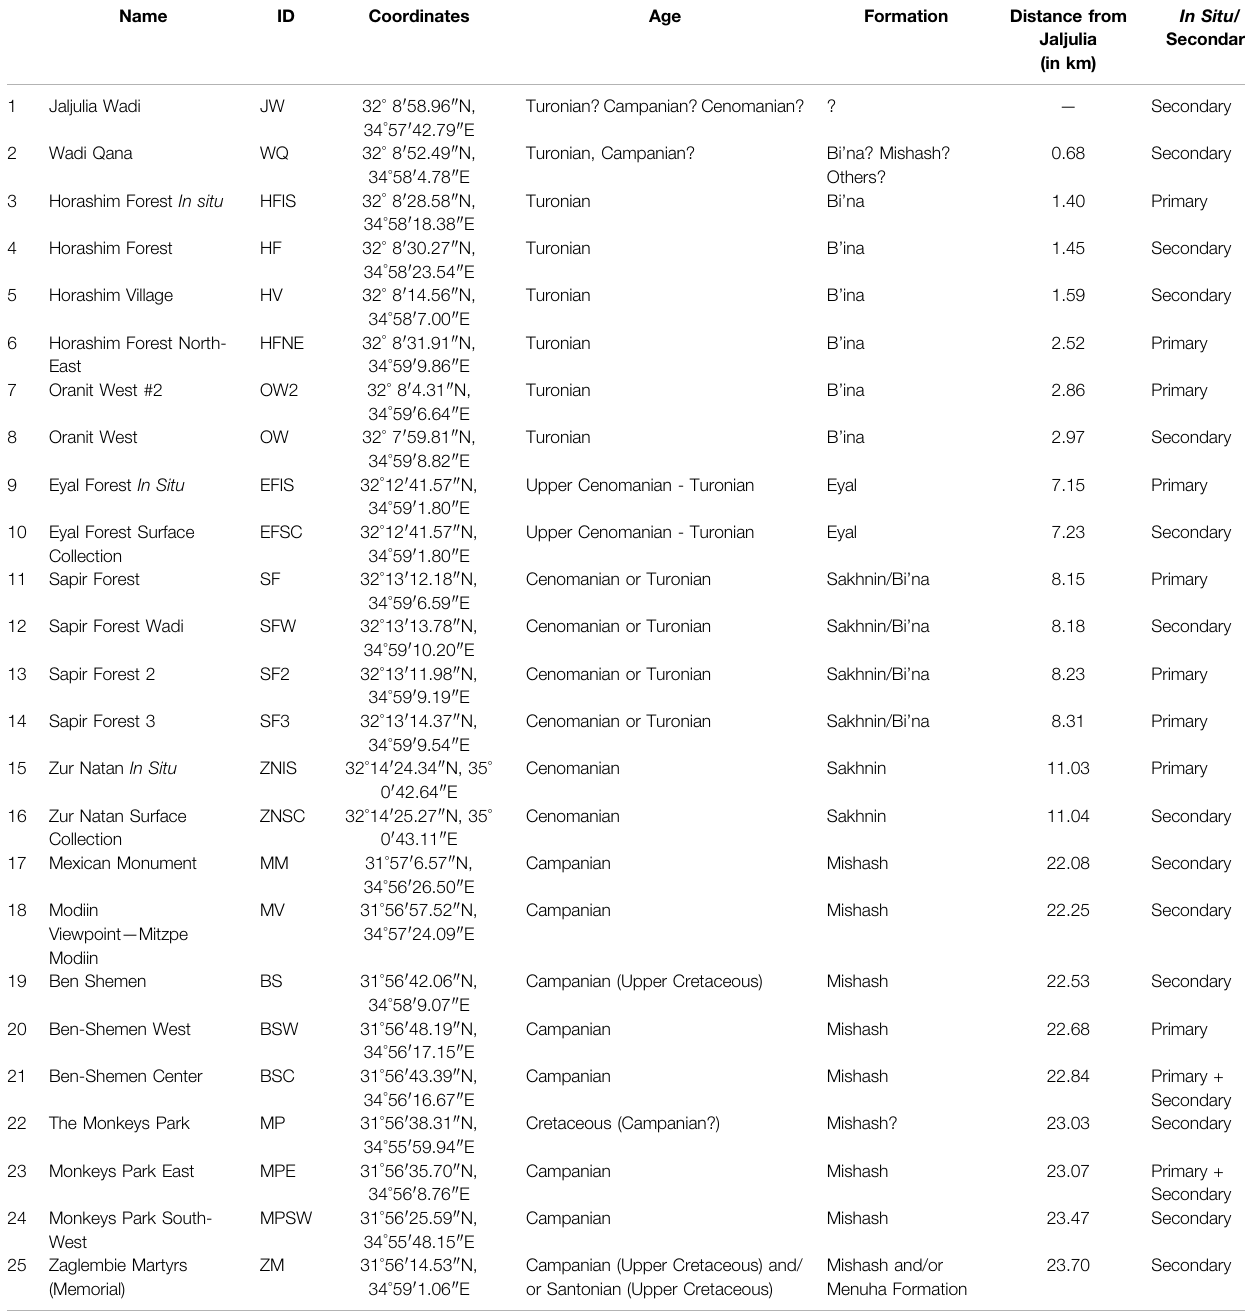
TABLE 4 | A full list of the identi fi ed potential fl int